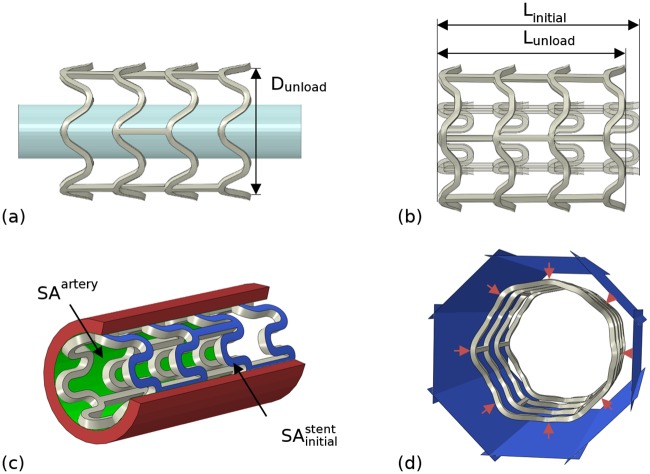
Schematic representations of tests for: (a) cross-sectional area (post-dilation), CSA; (b) foreshortening, FS; (c) stent-to-artery ratio, SAR and (d) radial collapse pressure, RCP.